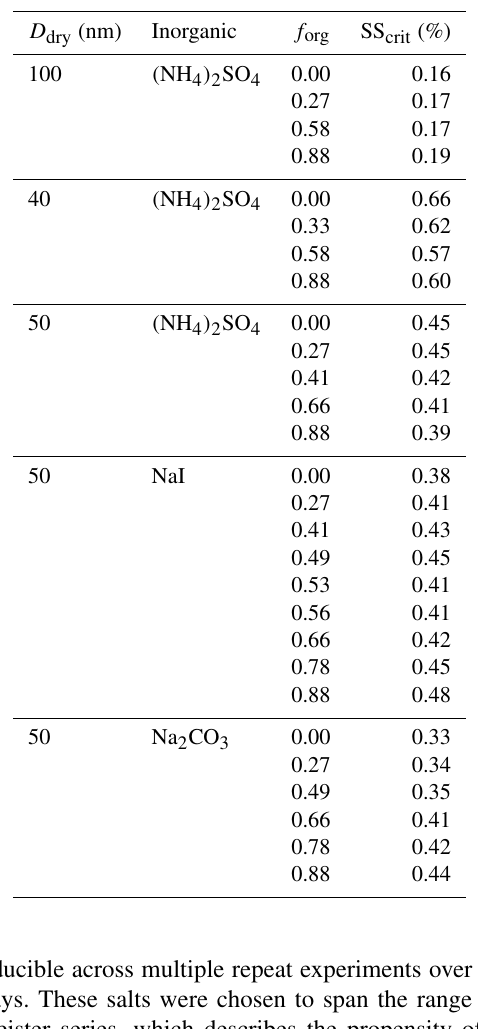
Table 3. Experimentally measured critical supersaturation for given dry diameter, inorganic particle core, and organic volume